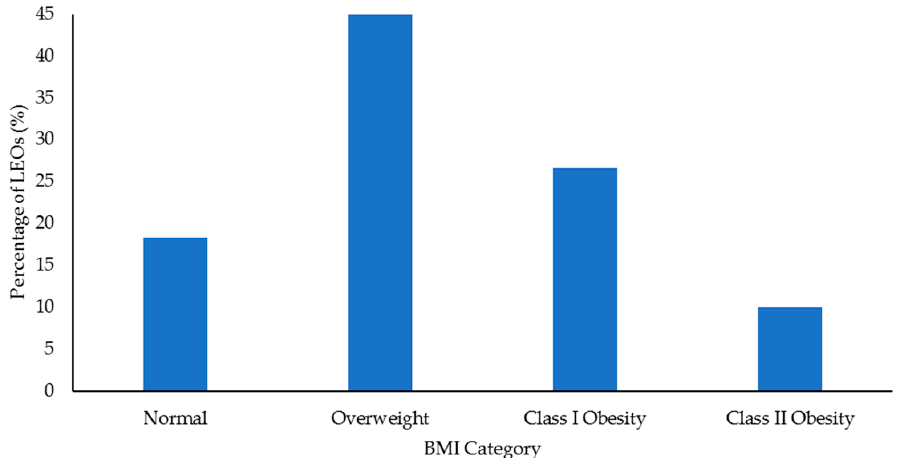
Figure 1. Percentage of law enforcement officers (LEOs) in this sample ( n = 60) classified according to the body mass index (BMI) categories.